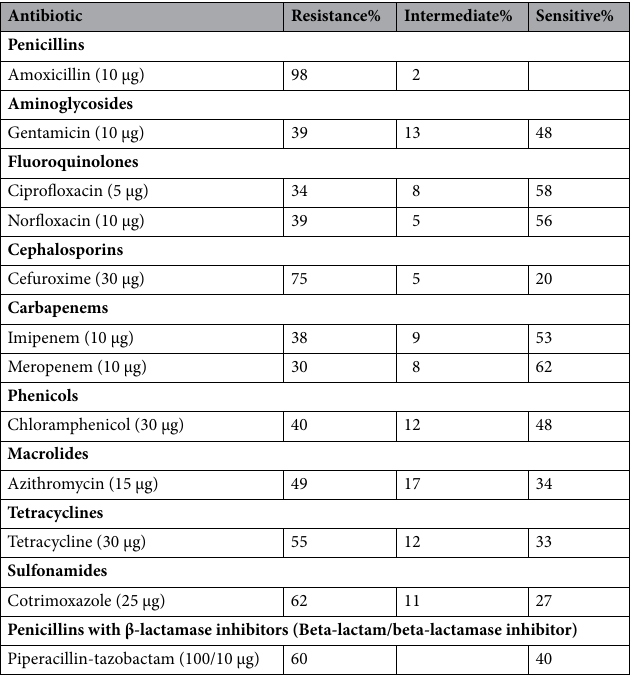
Table 1. Antibiotic susceptibility patterns of E. coli isolates (n = 100). n number of